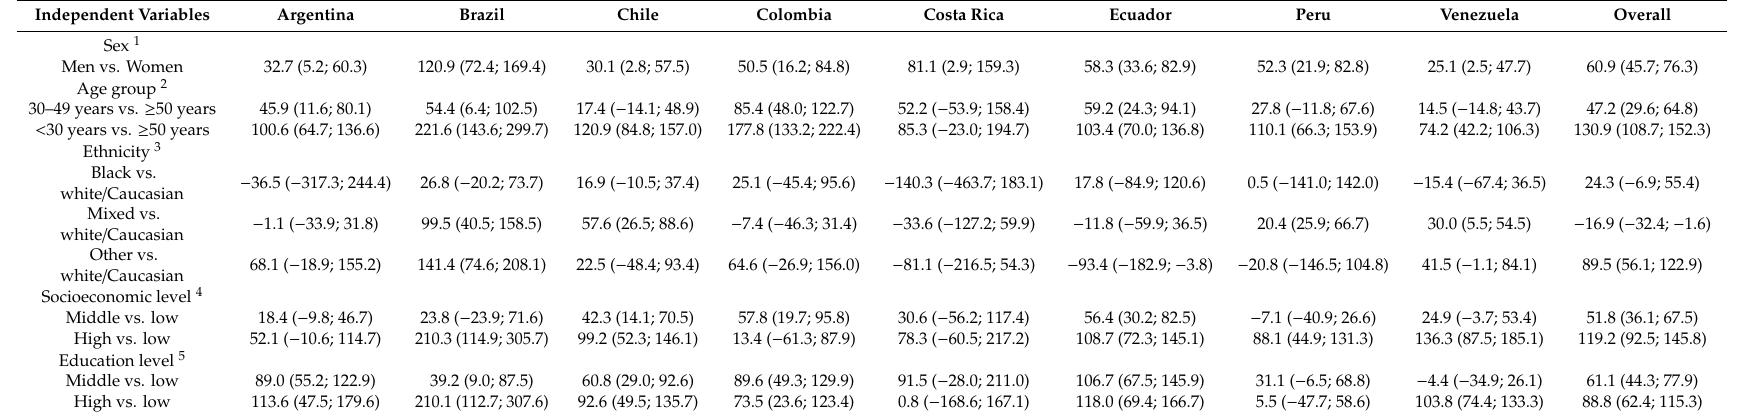
Table 2. Adjusted analyses ( b coe ffi cient (95% CI)) between independent variables and total sedentary behavior by country. Independent